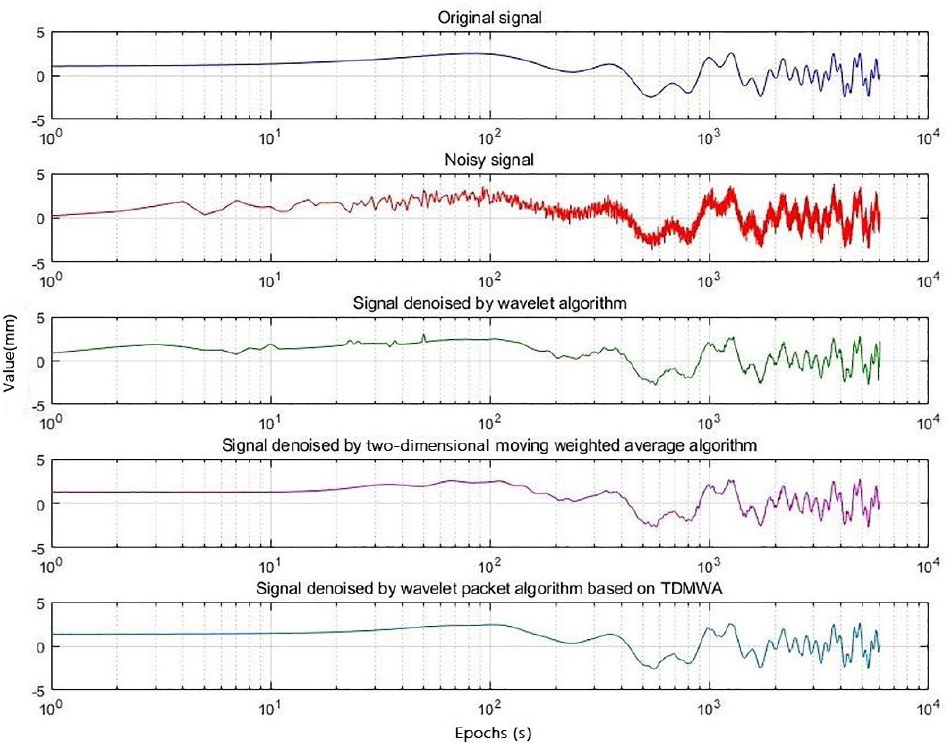
Figure 3. The signals denoised by the three different algorithms.